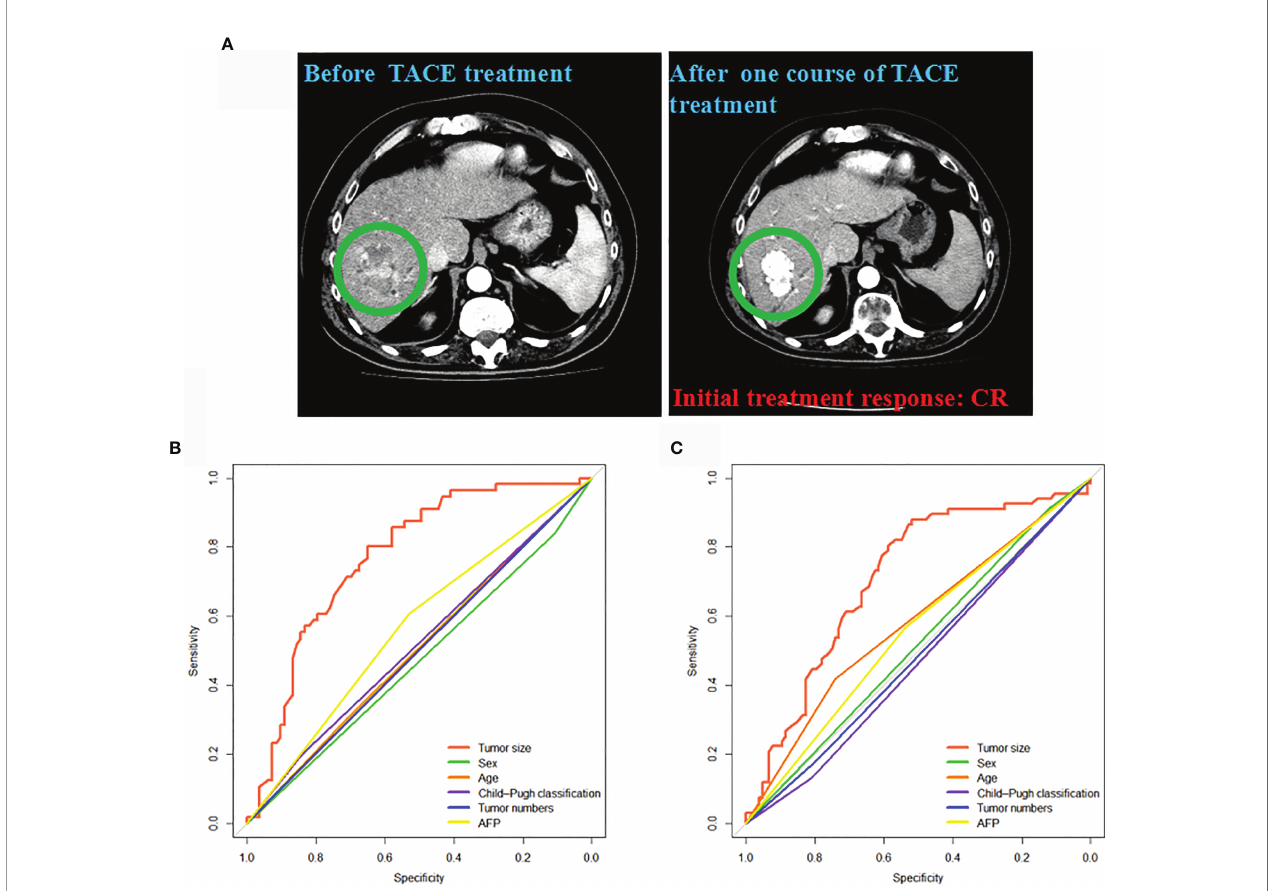
FIGURE 2 | Associations between the clinical factors and initial treatment response to TACE. (A) The CT images from a patient acquiring CR after one course of TACE treatment were presented. Clinical factors predicting response (CR + PR) in the training (B) and validation cohorts (C) . CR, complete response; PR, partial response; TACE, transarterial